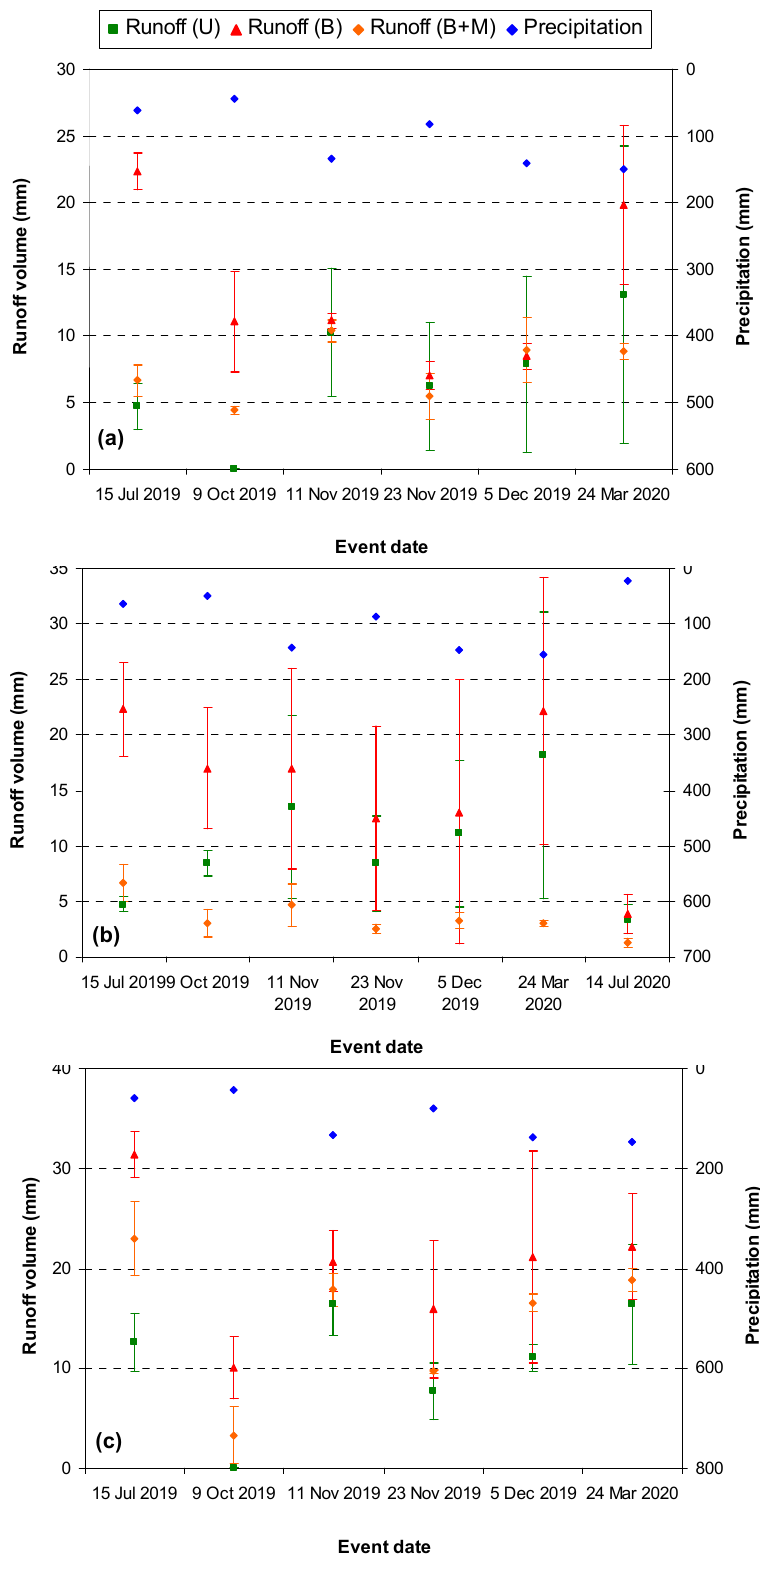
Figure 3. Precipitation and runoff volume (mean ± std. dev., n = 3 plots) measured in plots (( a ), pine; ( b ), chestnut; ( c ), oak) after prescribed fire and soil mulching using fern. Notes: U = unburned soils; B = burned and not treated soils; B + M = burned and mulched soils; no runoff was observed in pine and oak plots on 14 July 2020.